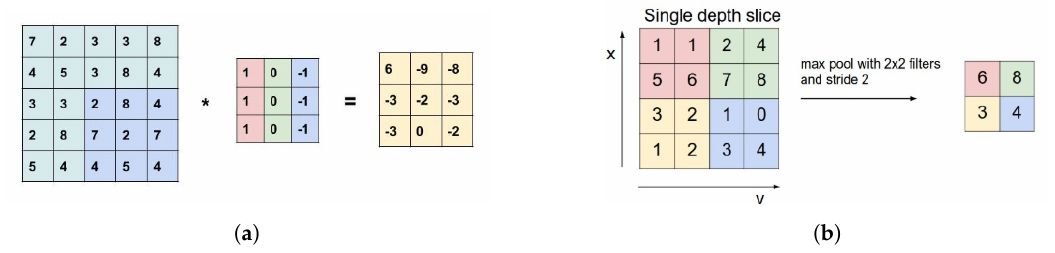
Figure 4. Matrix operators in convolutional neural networks. Convolution involves a sum of element by element multiplication, which in turn is the same as a dot product on multidimensional matrices which machine learning researchers call tensors. ( a ) Convolution. ( b ) Max